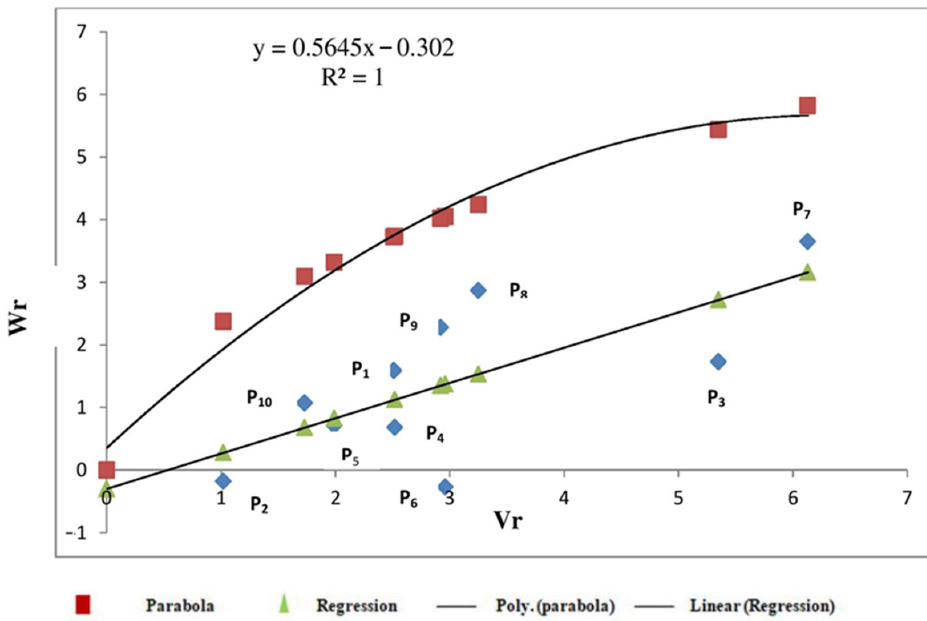
Figure 5. Wr–Vr graph for sedimentation value in E 3 . P1 = GW 451; P2 = GW 496; P3 = LOK 1; P4 = GW 322; P5 = GW 366; P6 = HI 1544; P7 = GW 173; P8 = GW 11; P9 = HD 2864; P10 = UAS 385.